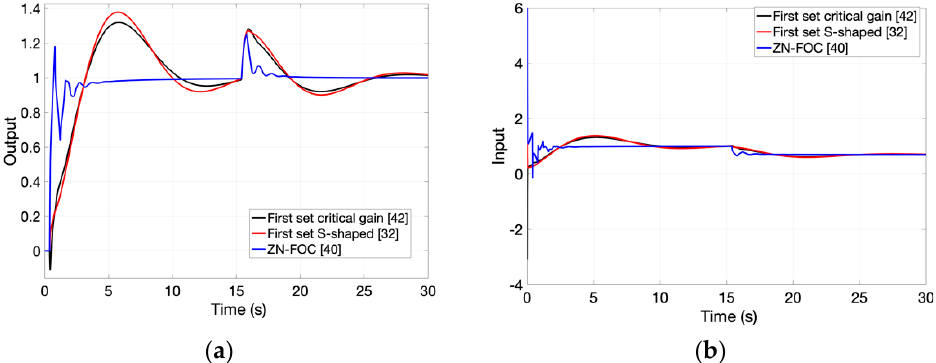
Figure 17. ( a ) Output signals for FO-PID control of delay-dominant process. ( b ) Input signals for FO-PID control of the delay-dominant process (controllers tuned according to [40,42] first set and [32] first set). Table 9. Closed-loop results obtained with the FO-PID controller for the delay-dominant process.